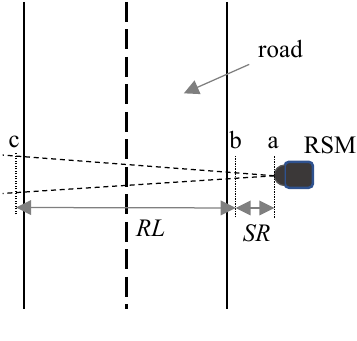
Fig. 3. Sensor installation scheme on the road